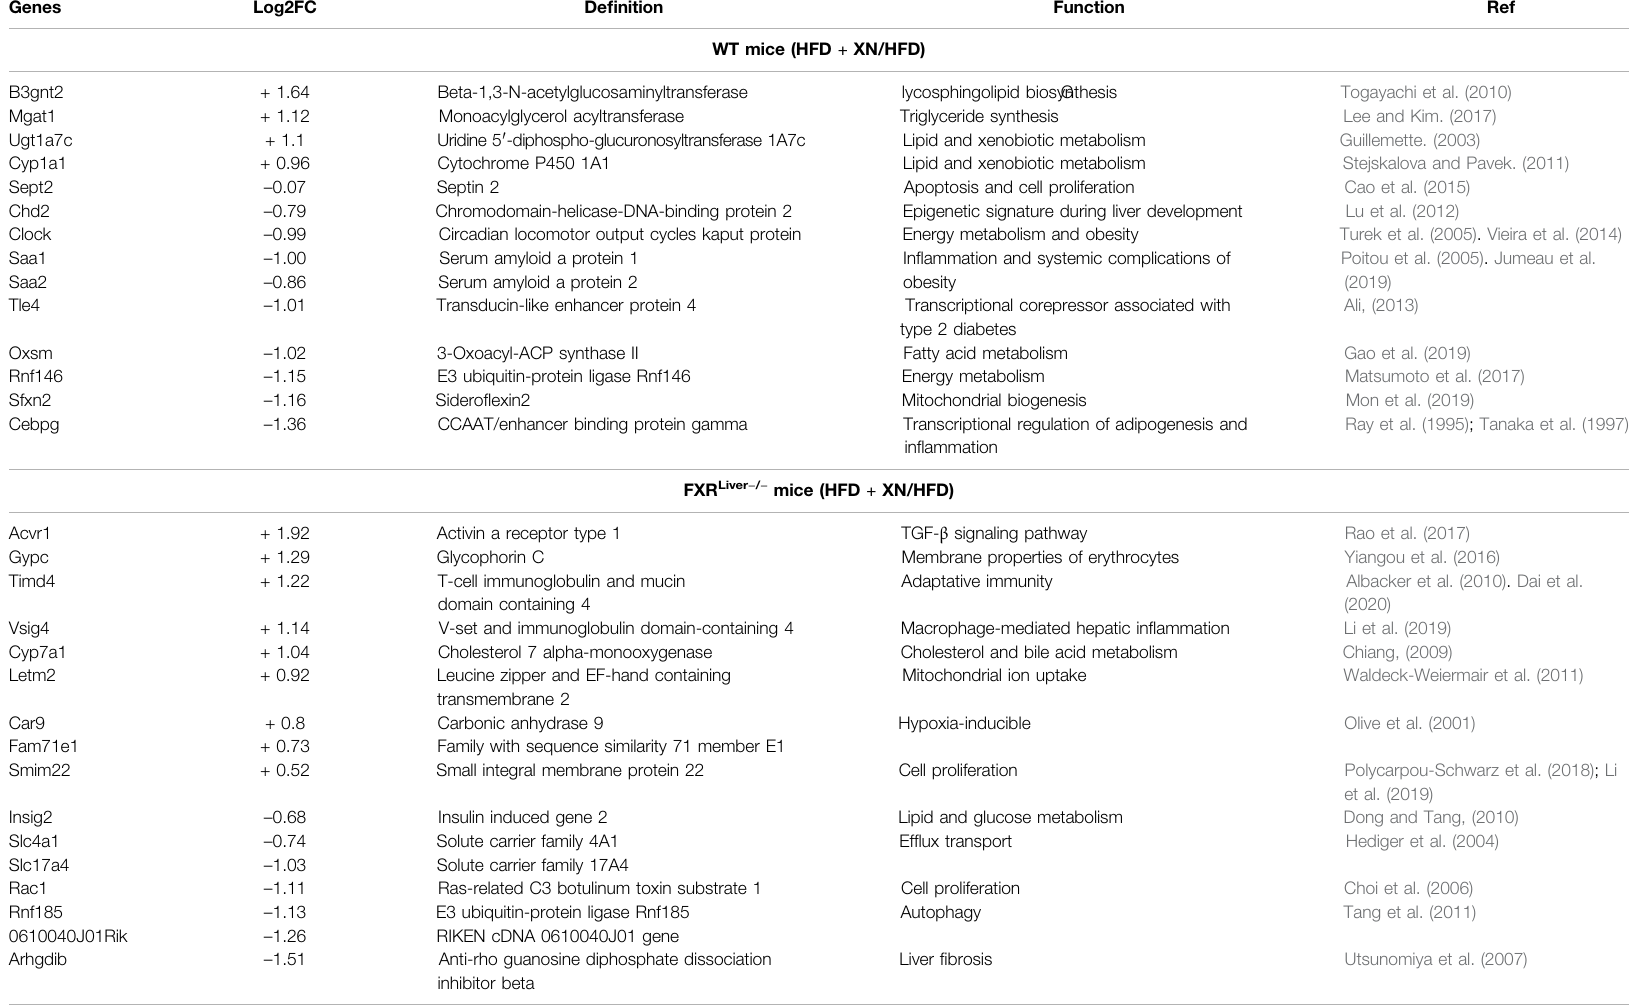
TABLE 3 | Hepatic genes regulated by XN in WT and FXR Liver − / − mice and their roles in metabolic function.